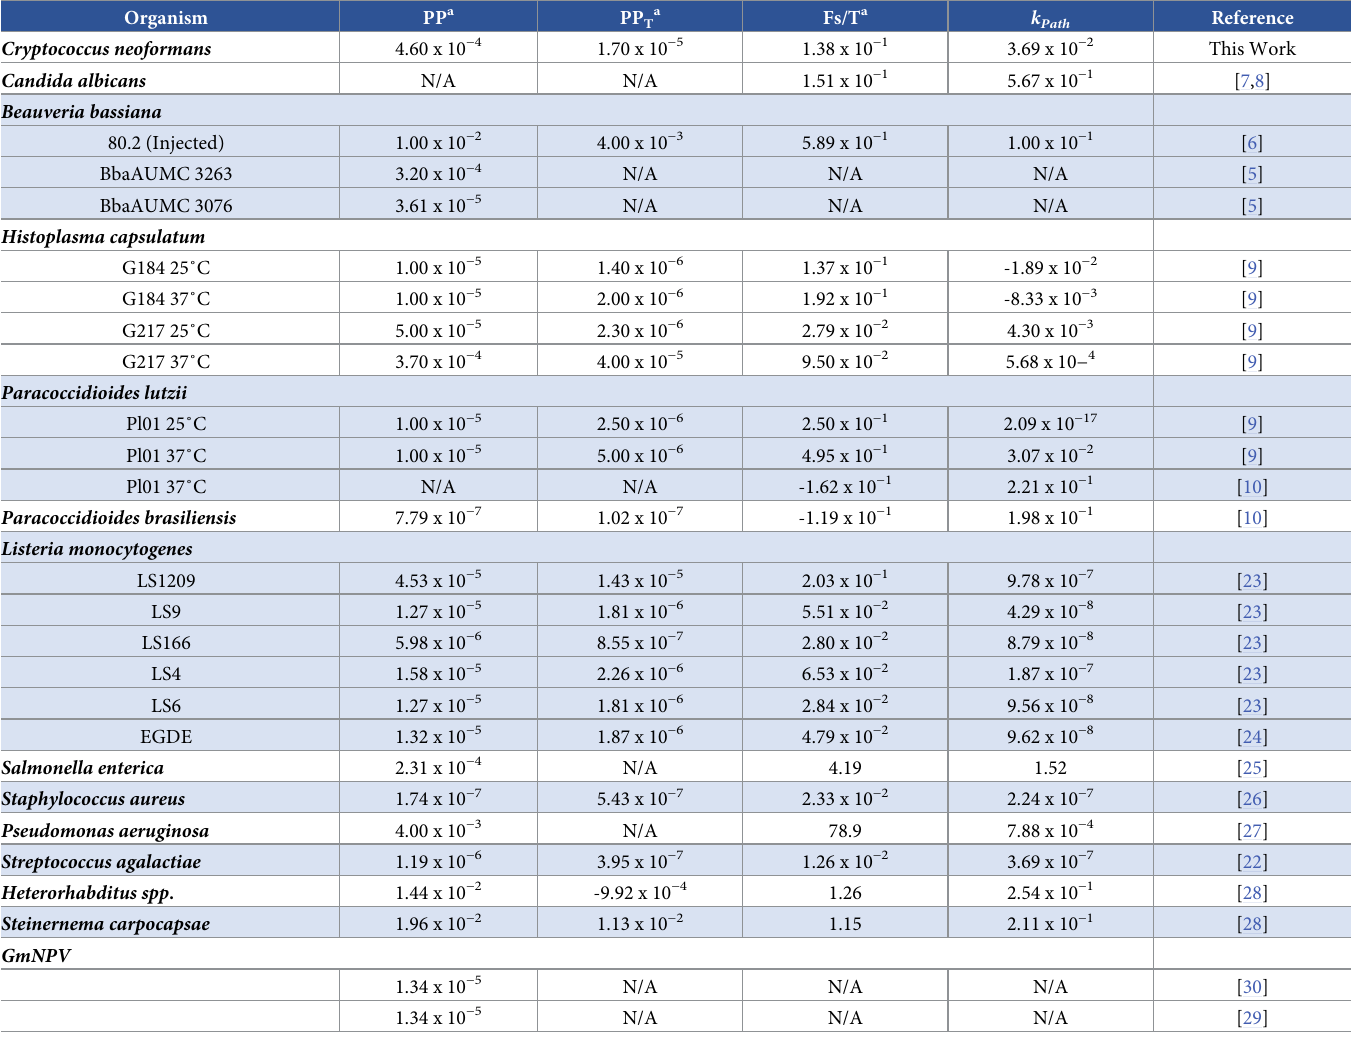
Table 2. Calculated PP , PP T , Fs/T , and k Path values for inoculum of 10 5 organisms or virions . tested. Organism